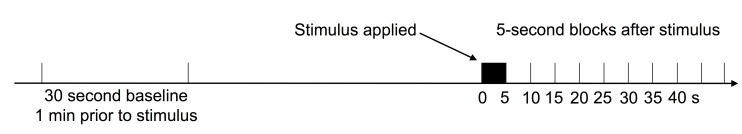
Diagram illustrating the generation of summary data used for statistical analyses of spectral EEG variables.